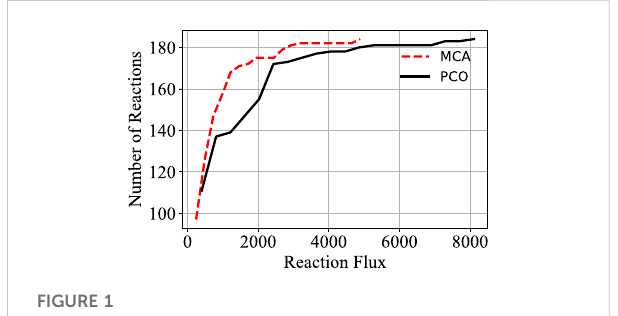
FIGURE 1 Comparison of the cumulative distribution of the reaction fl uxes for the MCA model and the PCO model. Flux through the growth reactions are maximized by turning reaction fl uxes down but not